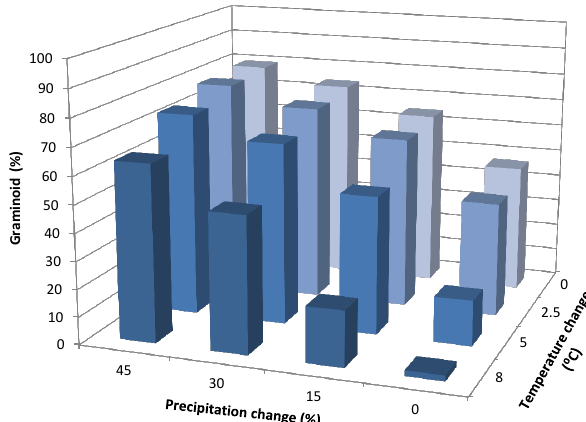
Figure 6. Percentage of graminoid biomass in the vascular plant community biomass, averaged over 2065–2074, for vegetation type 3 (initial moist mixed vegetation) for 16 temperature and precipita- tion scenarios in the 21st